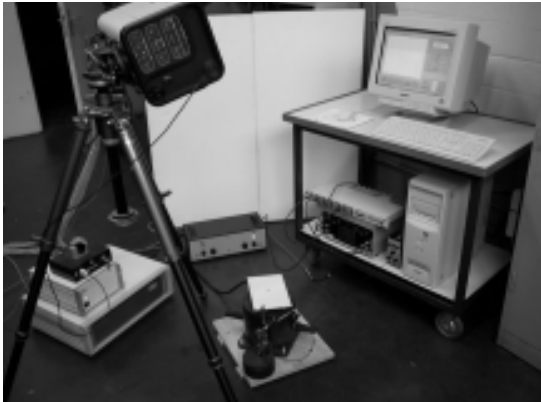
Fig. 2. Photo of the measurement